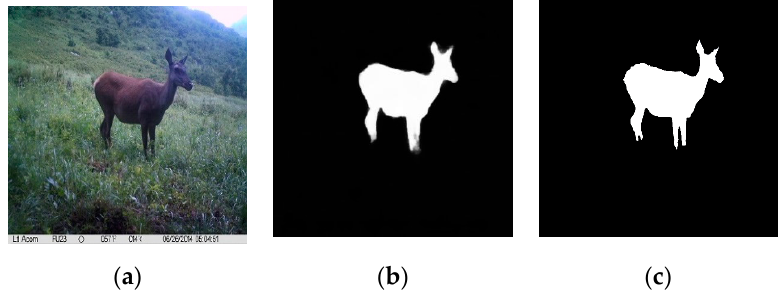
Figure 6. Saliency object detection and extraction. ( a ) Original image; ( b ) Saliency object region; ( c ) Ground truth.